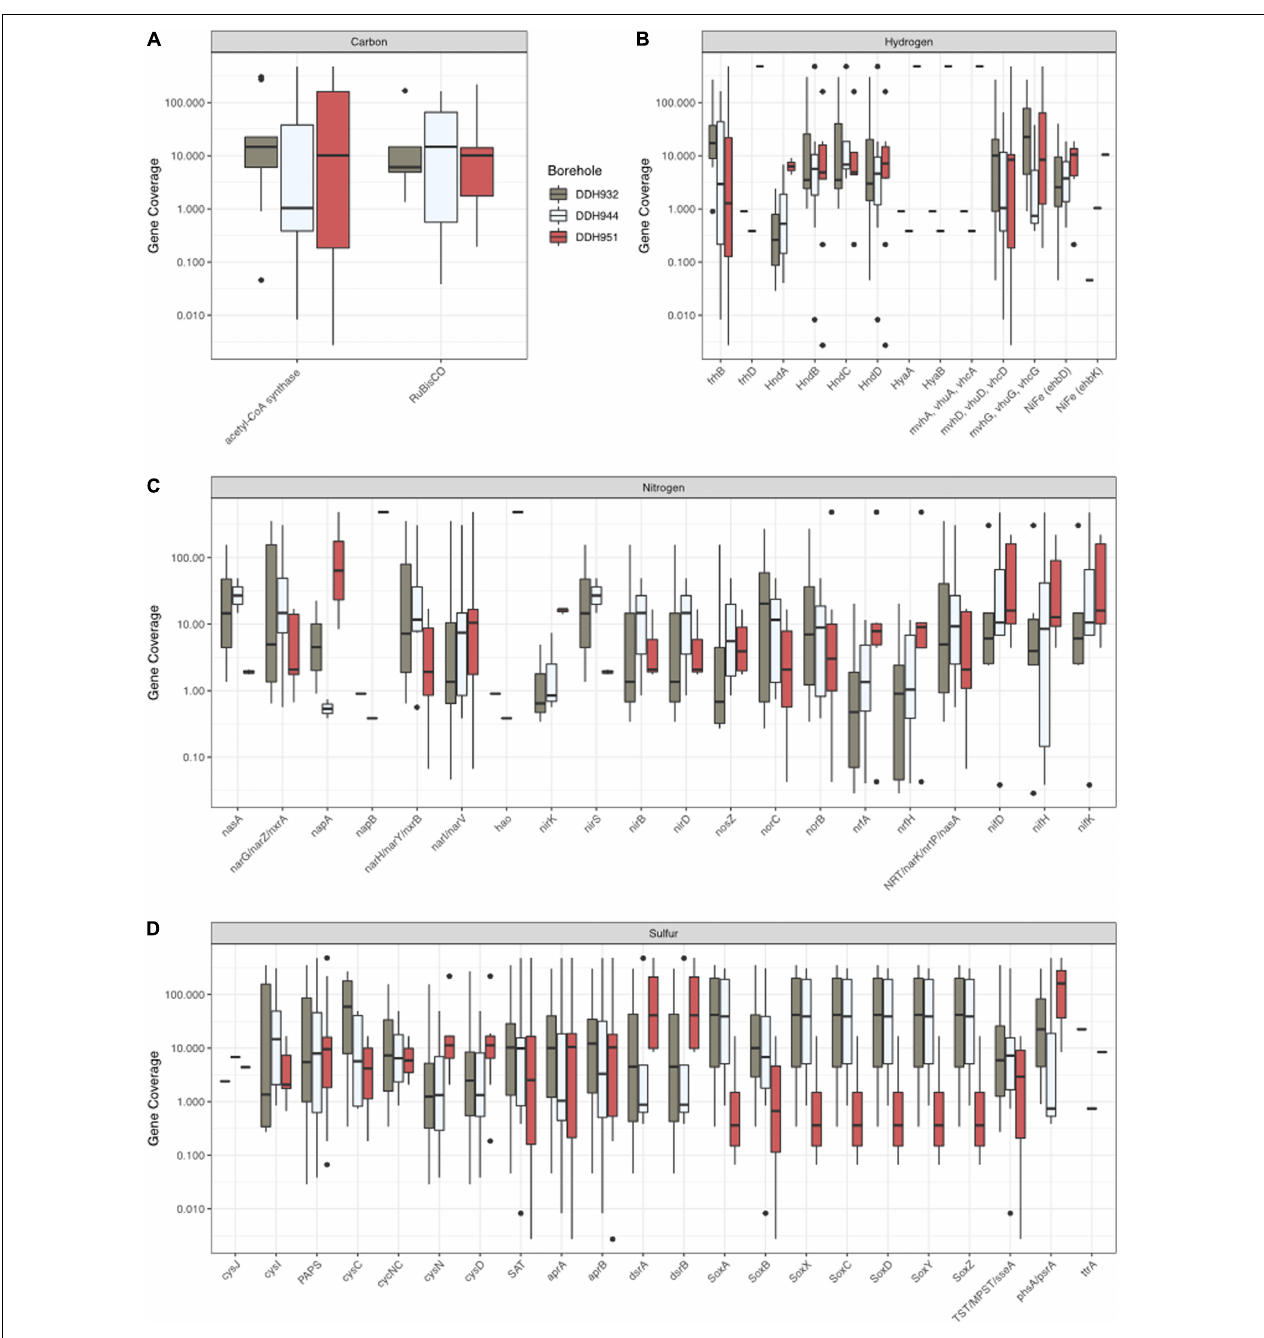
FIGURE 7 | The dominance of genes for carbon (A) , hydrogen (B) , nitrogen (C) , and sulfur (D) at each borehole. Gene coverage is based on the MAG coverage.